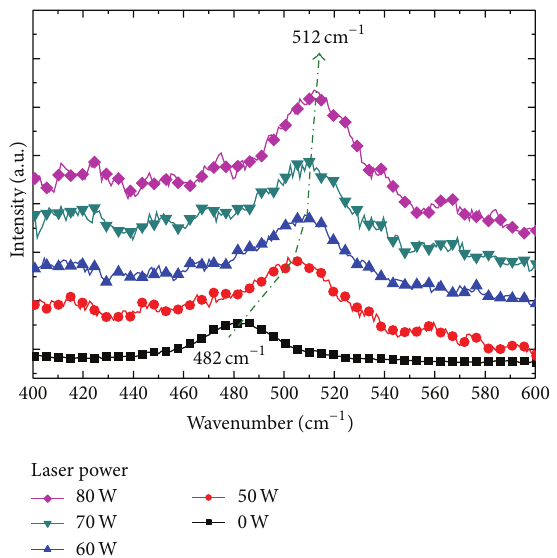
, 𝐽 , FF, and 𝜂 of oc sc